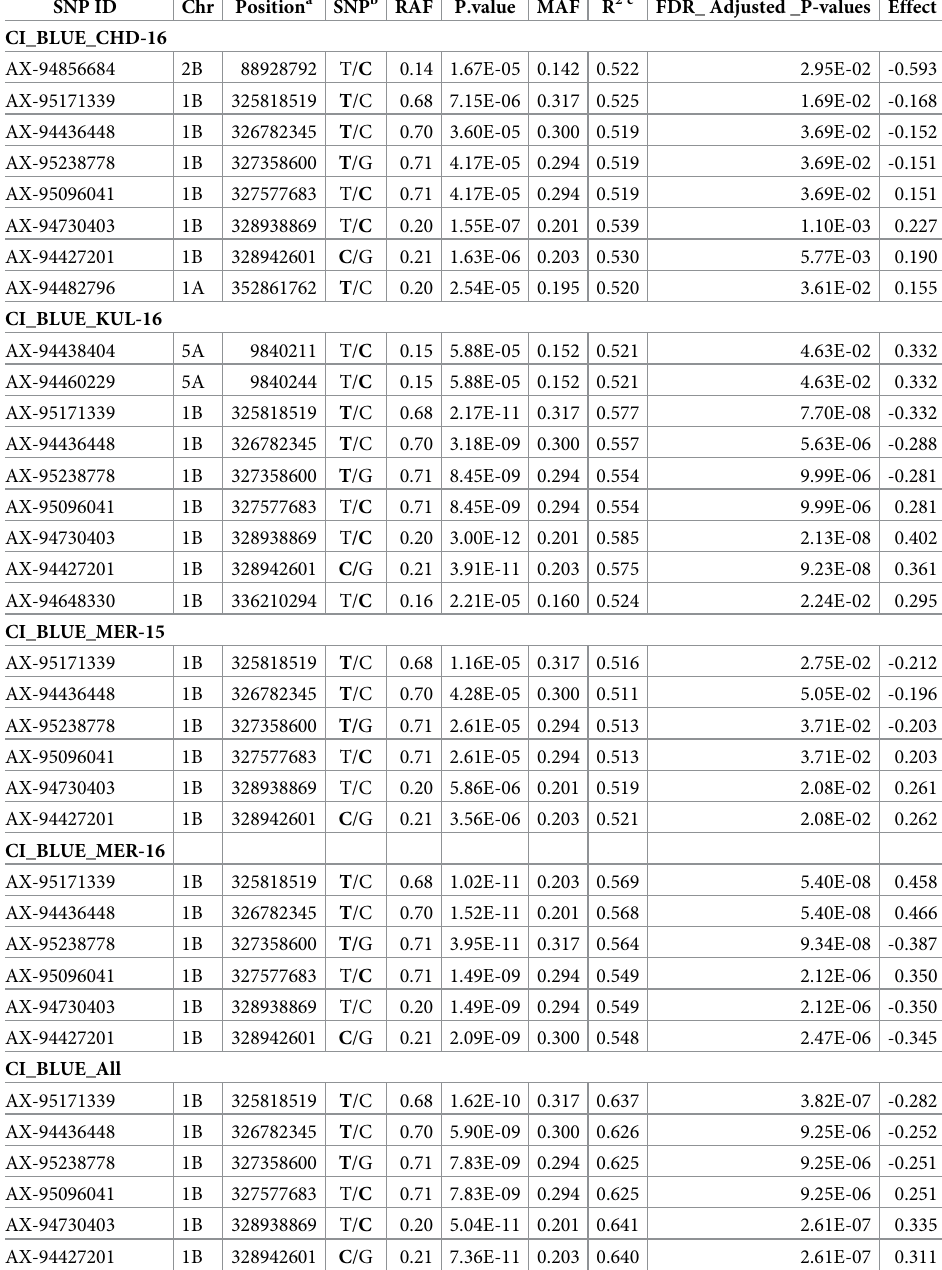
Table 6. SNPs significantly associated with Yellow rust resistance identified by GWAS